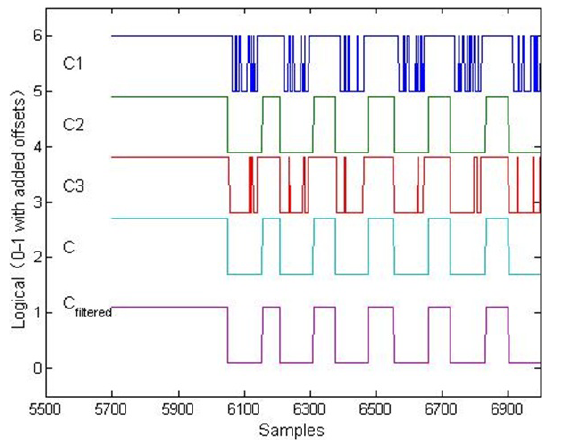
Figure 2. The logical value of multi-condition step